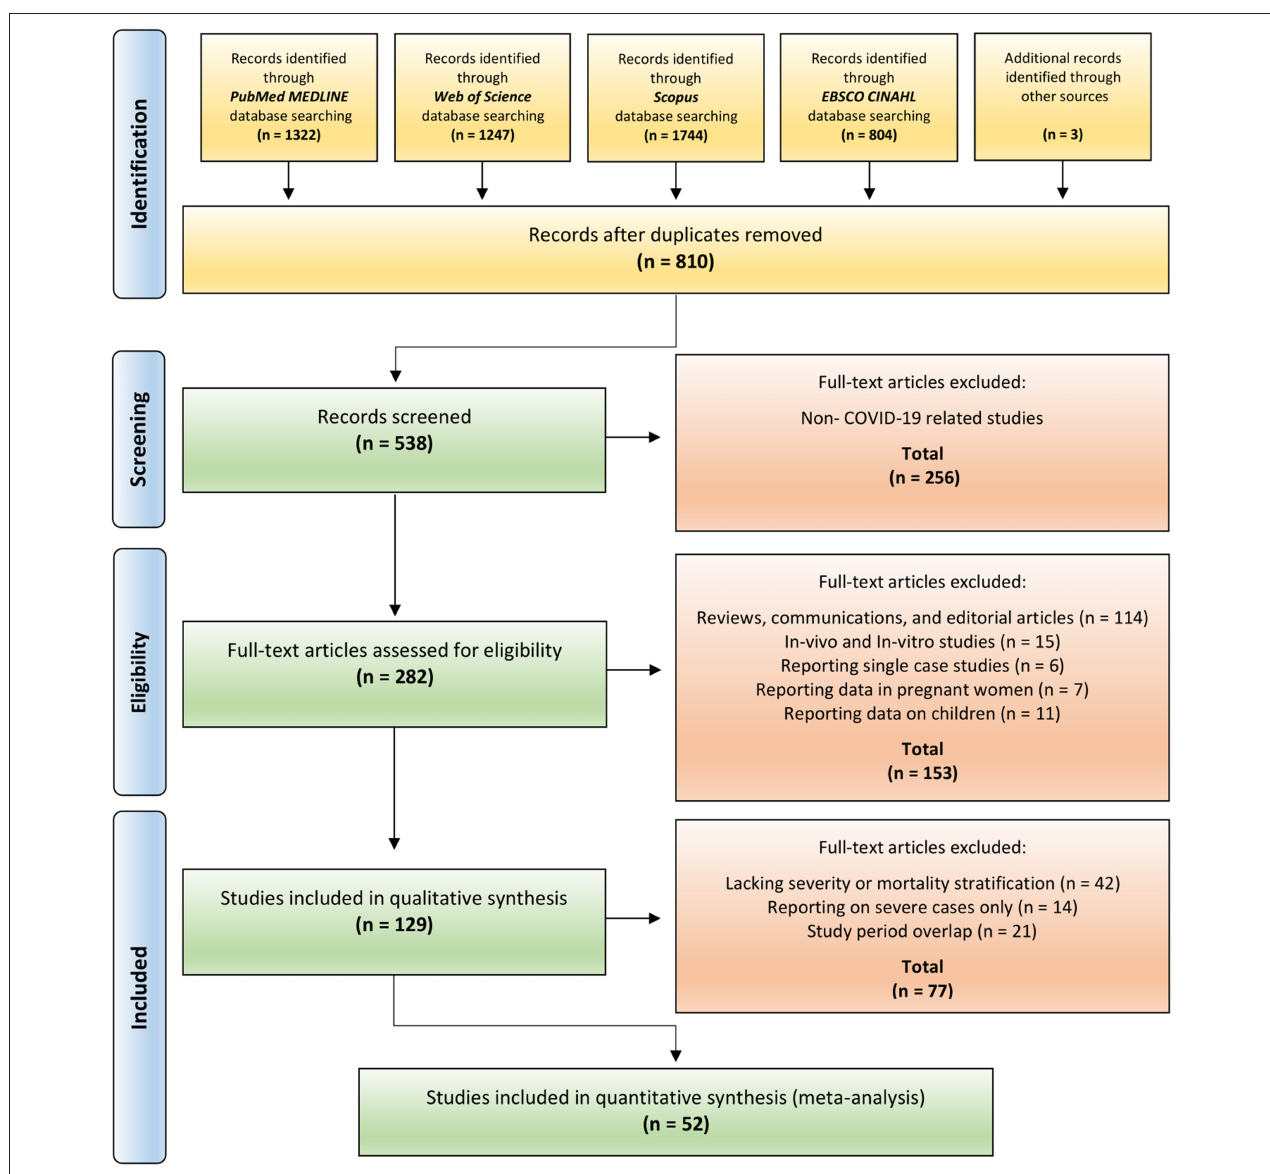
FIGURE 1 | PRISMA flow diagram for T-cell subsets and IL-10 in COVID-19 studies. Figure is adapted from PRISMA flow diagram 2009